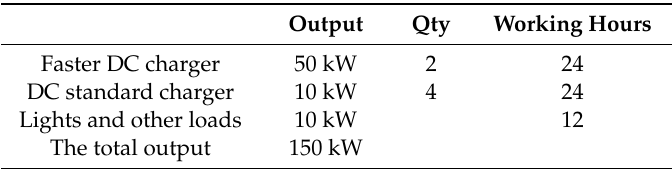
Table 1. The output of the charging station.